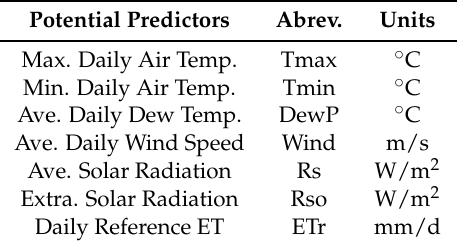
Table 3. Potential atmospheric predictors considered in this study.